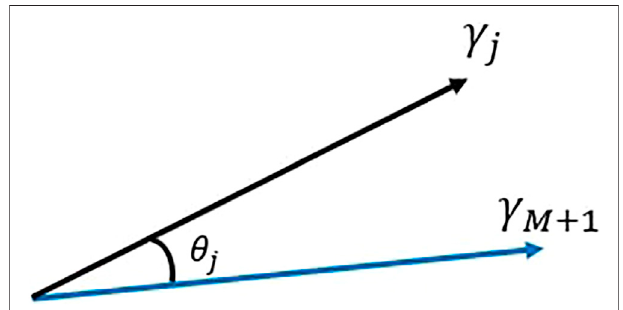
FIGURE 2 | Geometrical interpretation for the similarity index, c k